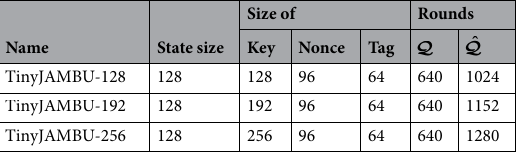
Table 1. TinyJAMBU variants and their recommended parameters.